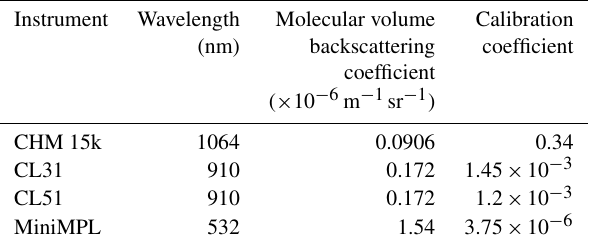
Table 5. Theoretical molecular volume backscattering coefficient calculated at pressure 1000hPa and temperature 20 ◦ C along with the calibration coefficient, relative to the instrument native units, determined for the instrument based on the molecular volume backscattering coefficient and stratocumulus lidar ratio calibration